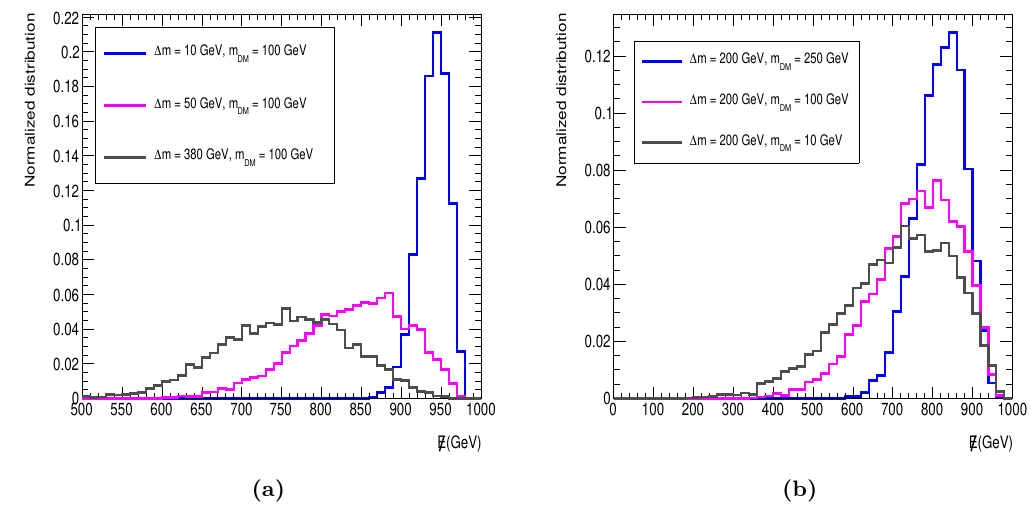
Figure 2. Normalised /E distribution at e + e − collider with (a) fixed DM mass, different ∆ m and with (b) fixed ∆ m , different DM mass (see figure insets for details). We consider pair production of singly charged scalar HDSP of an inert scalar doublet, which further decays to DM in association √ with on/off shell W ± bosons at s = 1000